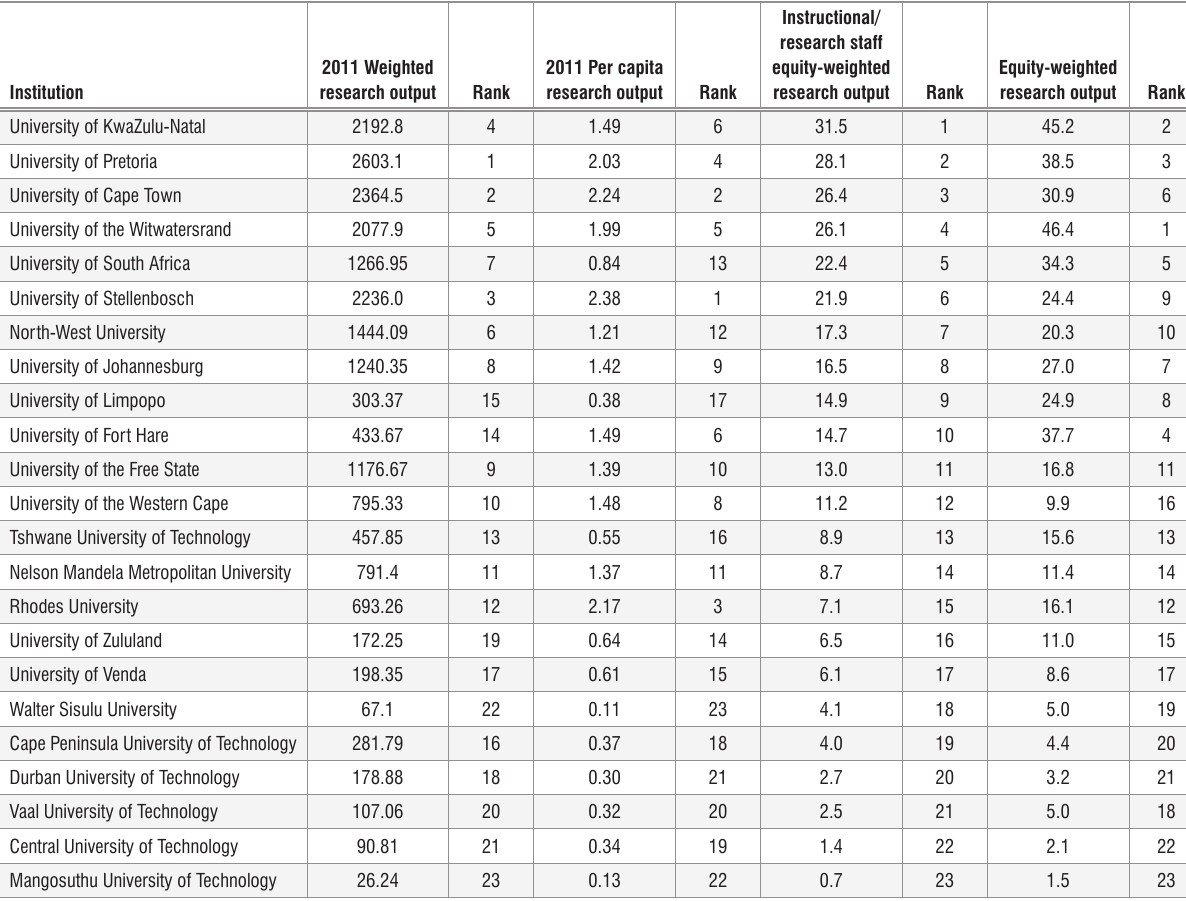
Table 6: Weighted and equity-weighted research